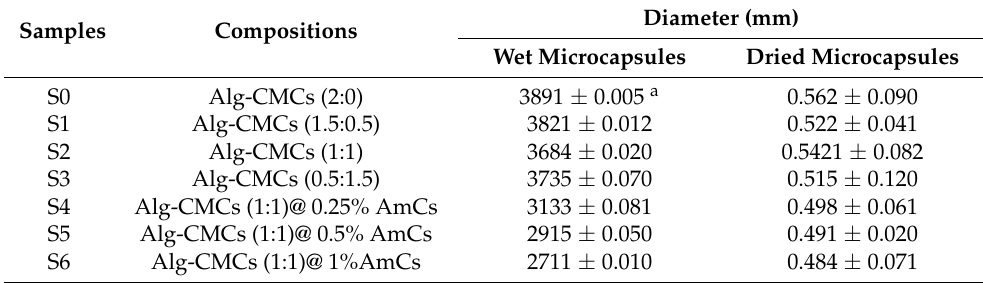
Table 1. Compositions and average diameter of the developed